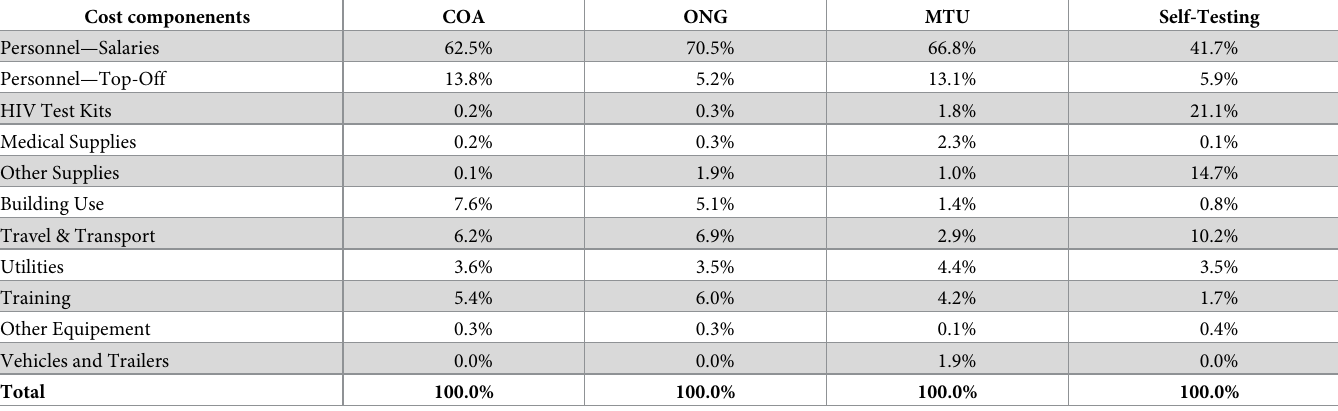
Table 5. Distribution of cost components according to the AHA´s strategies—Curitiba/PR/Brazil. Cost